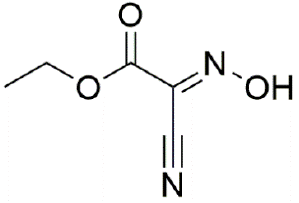
Figure 1. Chemical structure of Oxyma.